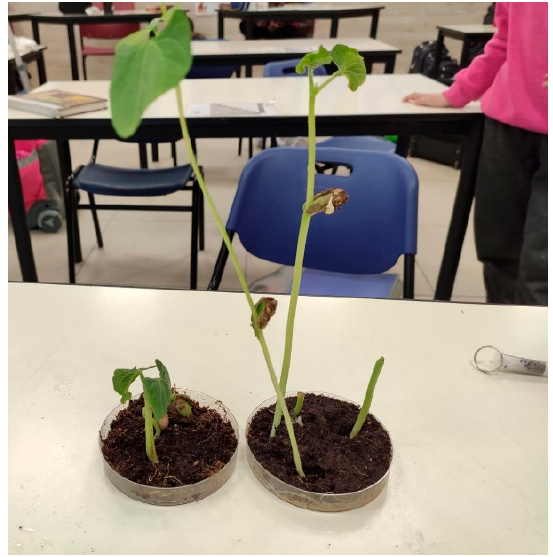
Figure 2. The pupils during the bean experiment .